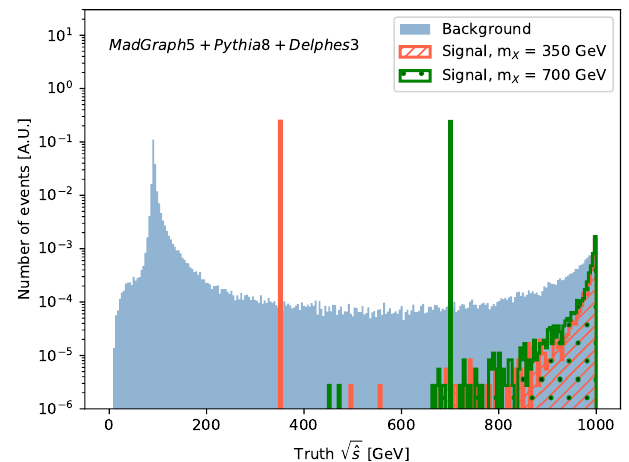
Figure 2. Effective center-of-mass energy calculated from truth-level quantities for the background and two signal processes